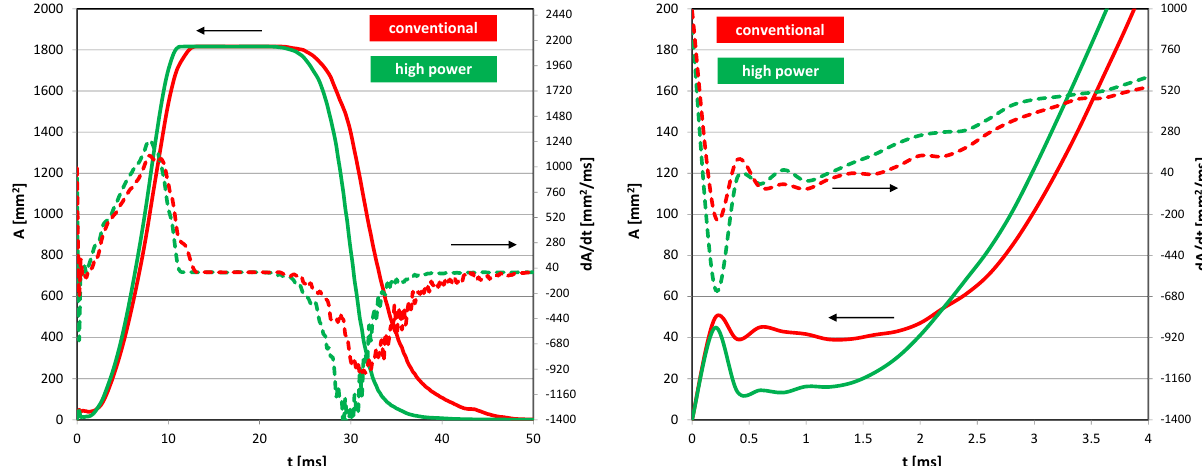
Fig. 9. Average flame area in the combustion chamber as a function of time (solid line) and its derivative (dashed line) for the entire combustion process (left), and early stage of flame development